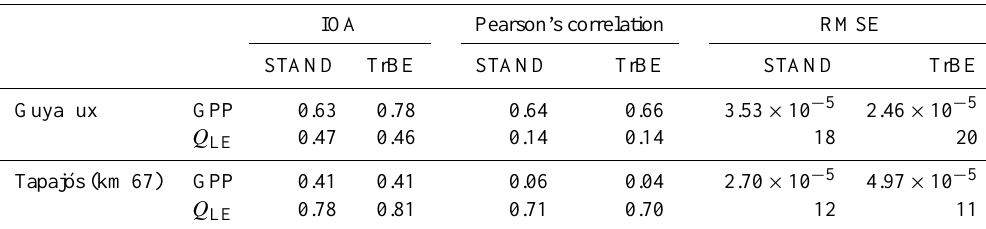
Table 3. Goodness of fit evaluation statistics for standard (STAND) and modified ORCHIDEE (TrBE) modelled gross primary production (GPP) and latent heat ( Q LE ) evaluated against flux tower data at Guyaflux and Tapaj´os (km 67).